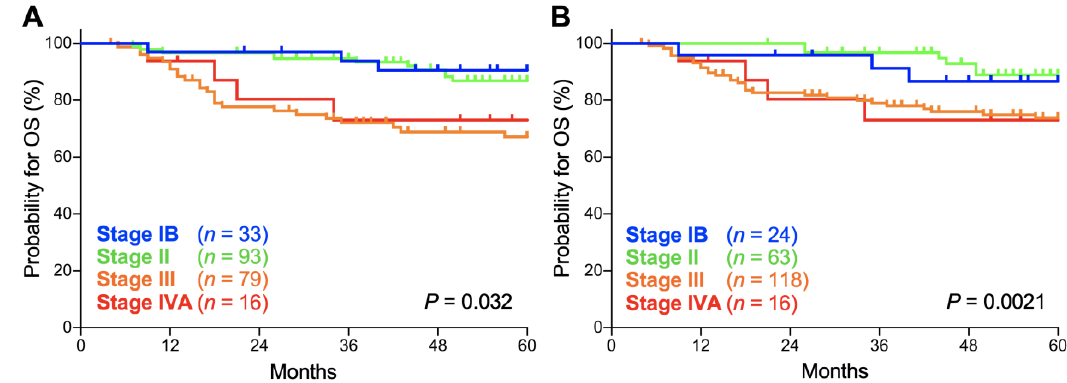
Figure 2. Kaplan–Meier estimates of overall survival (OS) for patients with squamous cell carcinoma of the cervix according to the International Federation of Gynecology and Obstetrics (FIGO) 2009 ( A ) or 2018 ( B ) classification. p values calculated from the log-rank test for trend are shown.